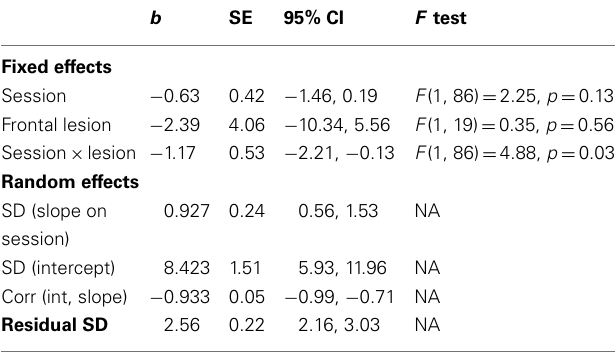
Table 2 | Results of MLM analysis of Chen et al. (2012) data.